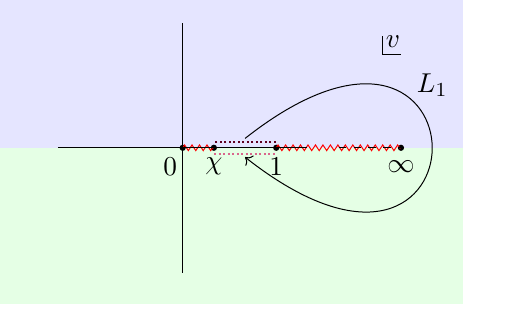
Figure 10 . Left: one sheet of the boundary geometry B 2 , 2 with the generator L 1 of the Schottky group corresponding to non-trivial monodromy around the cycle containing one of the branch cuts. ˜ Right: the image of B in the y -plane with the two circles C C 1 identified by the action of the 2 , 2 1 , Schottky group and their interiors removed to give the fundamental domain. The upper and lower y -plane are related by the Z 2 replica symmetry with each corresponding to a sheet of B 2 , 2 .